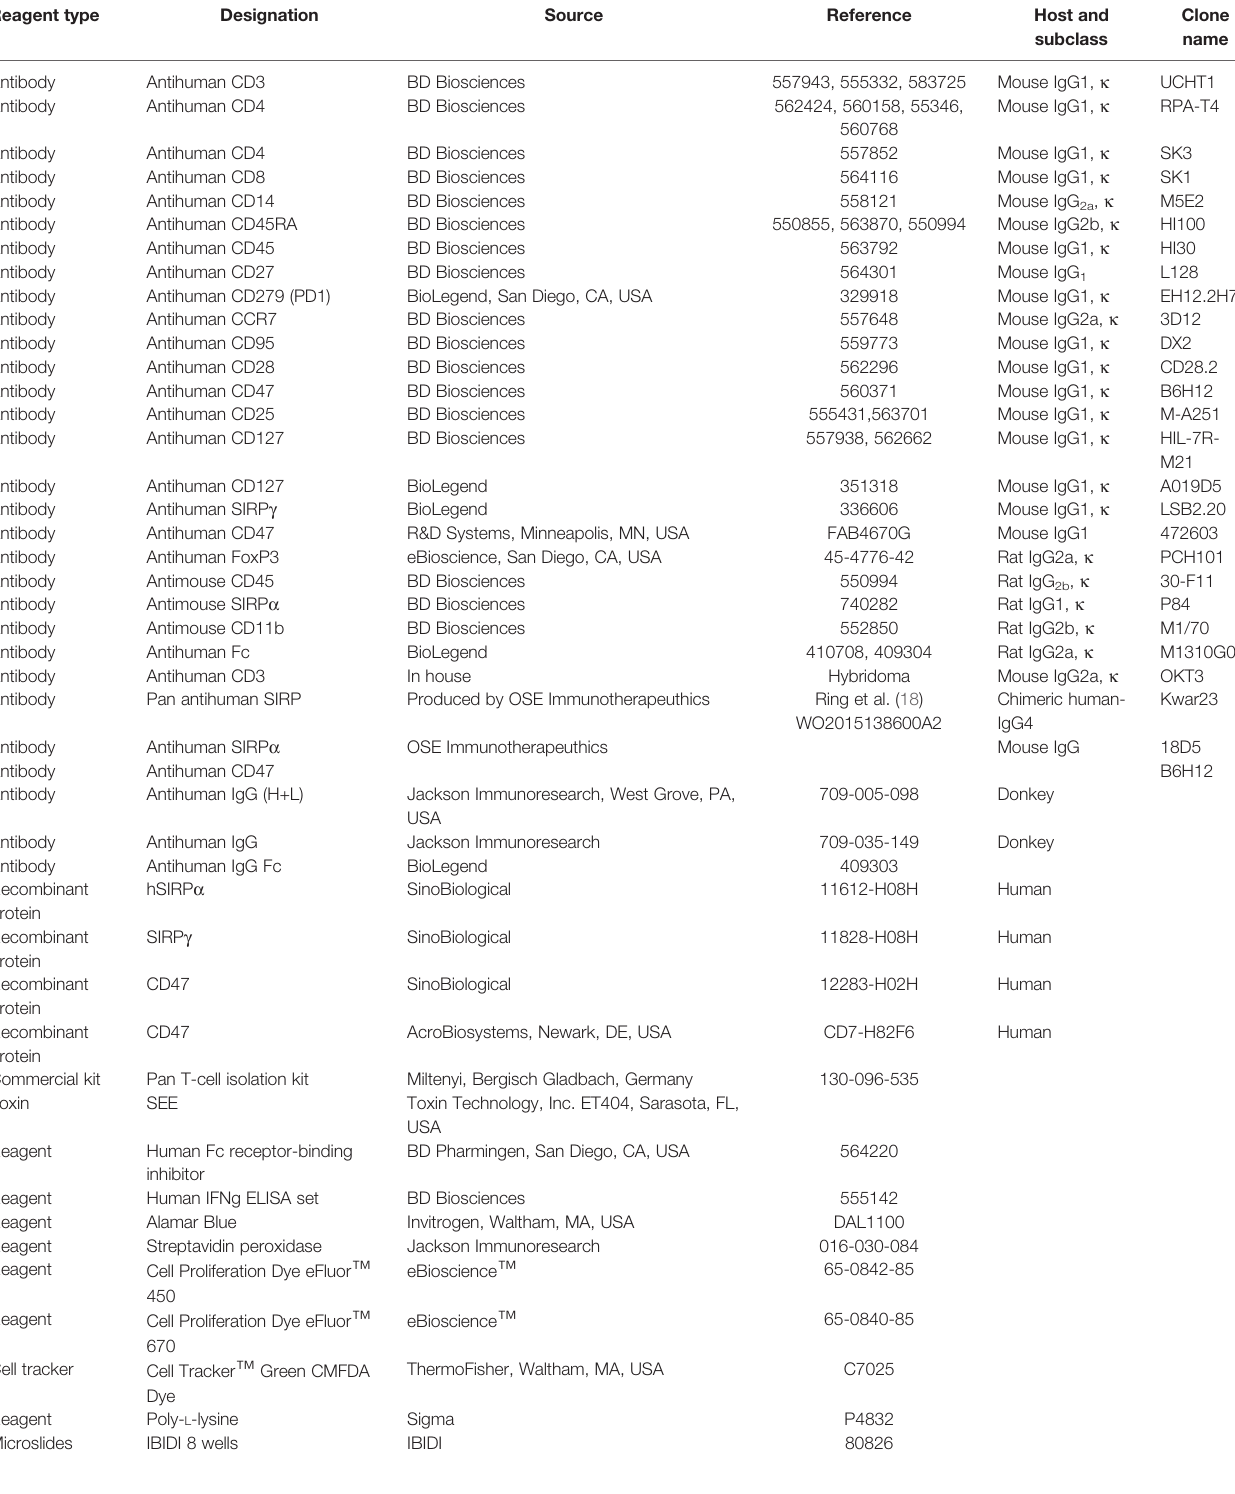
TABLE 1 | Key resource